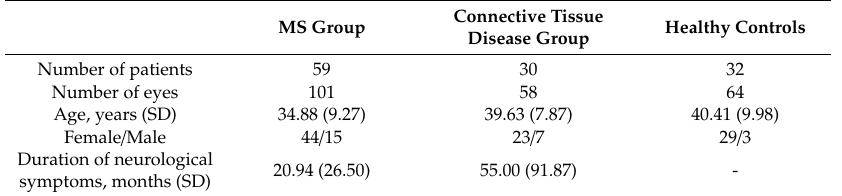
Table 1. Age, gender, and time from the occurrence of first neurological symptoms in each group.